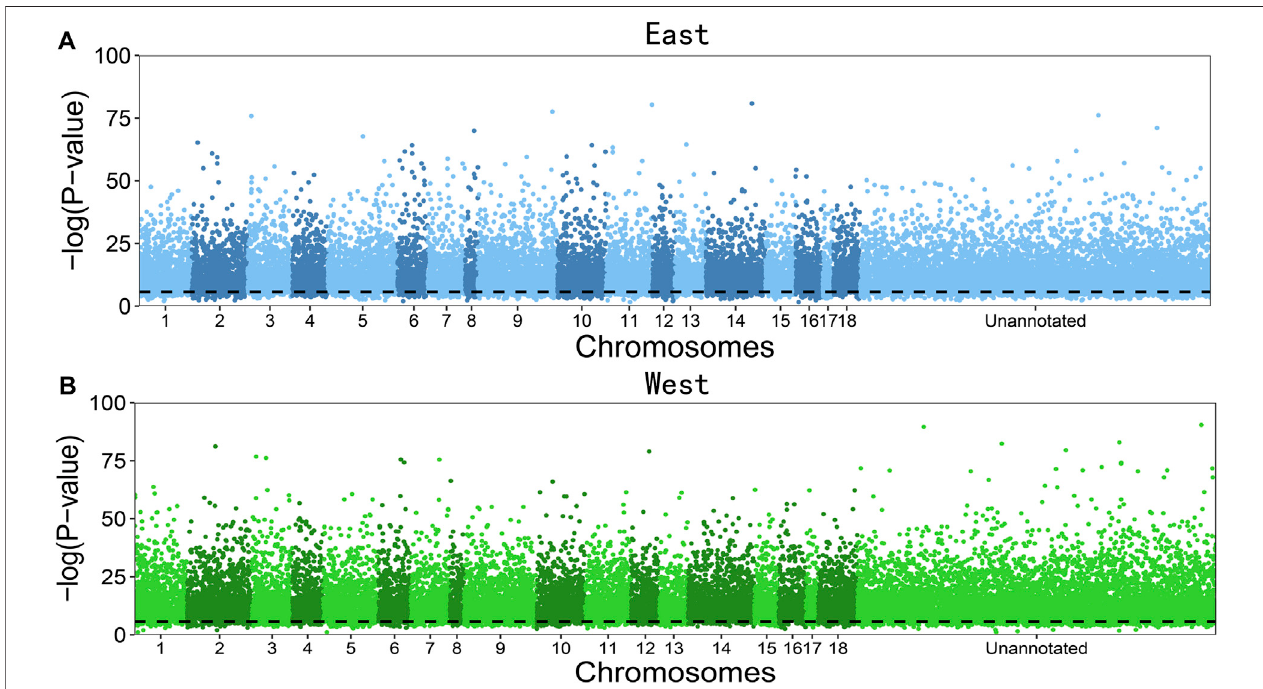
FIGURE 2 | Manhattan plots of signi fi cance test for marker aHWE throughout the genome in an allooctoploid switchgrass upland ecotype collected from eastern (A) and western populations (B) . SNPs with unknown chromosomes are given in the “ unannotated ” part. Horizontal line denotes the signi fi cance level after Bonferroni